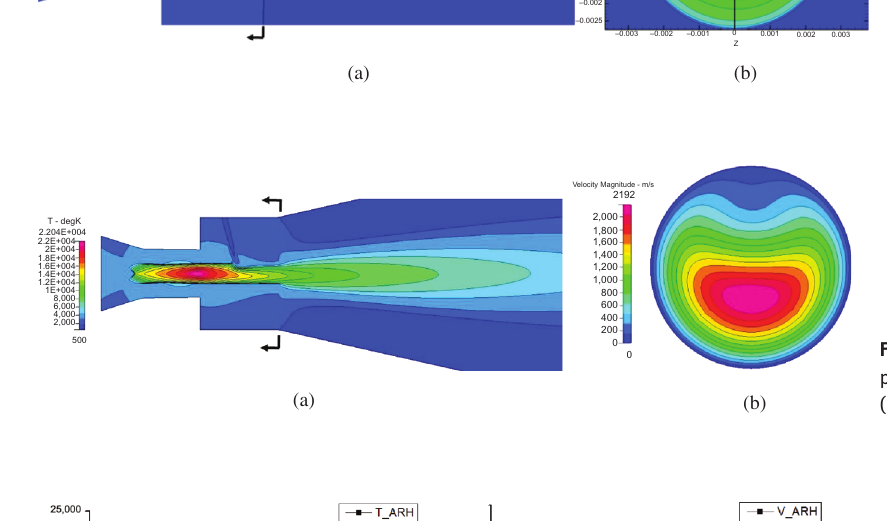
Figure 6: The influence of H2 on gas tem- perature (a) and velocity (b), which were calculated with initial total gas flow rate of 60 splm, carrier gas flow rate of 7 slpm, gas inlet pressure of 0.8 Mpa, electron current of 420 A, power of 65